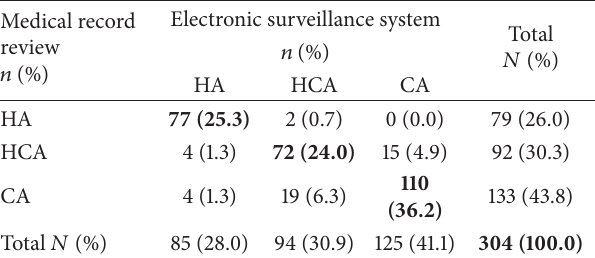
Table 2: Location of acquisition determined by the electronic surveillance system and the medical record review among concor- dant episodes of bloodstream